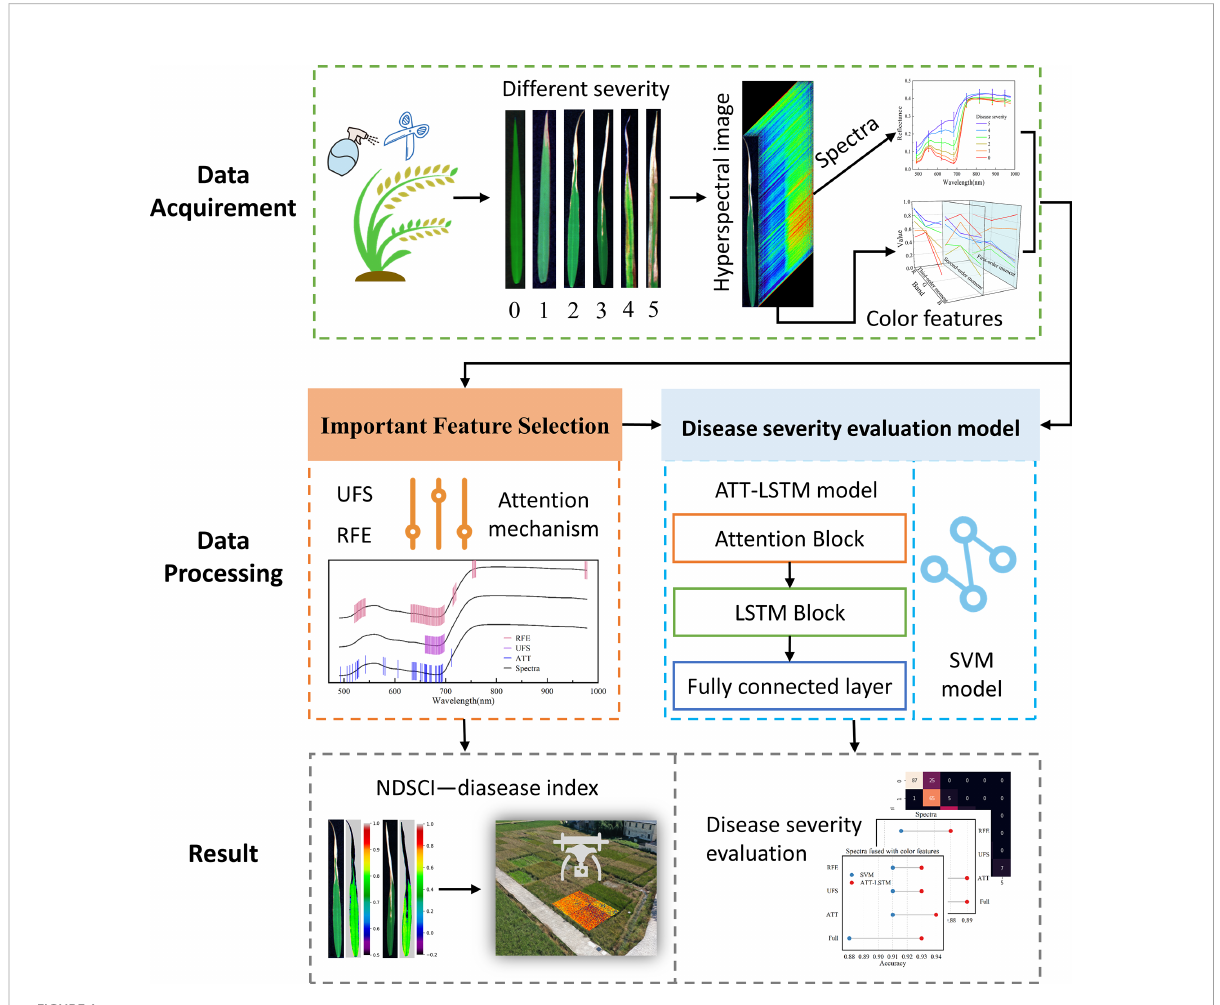
FIGURE 1 Work fl ow of the